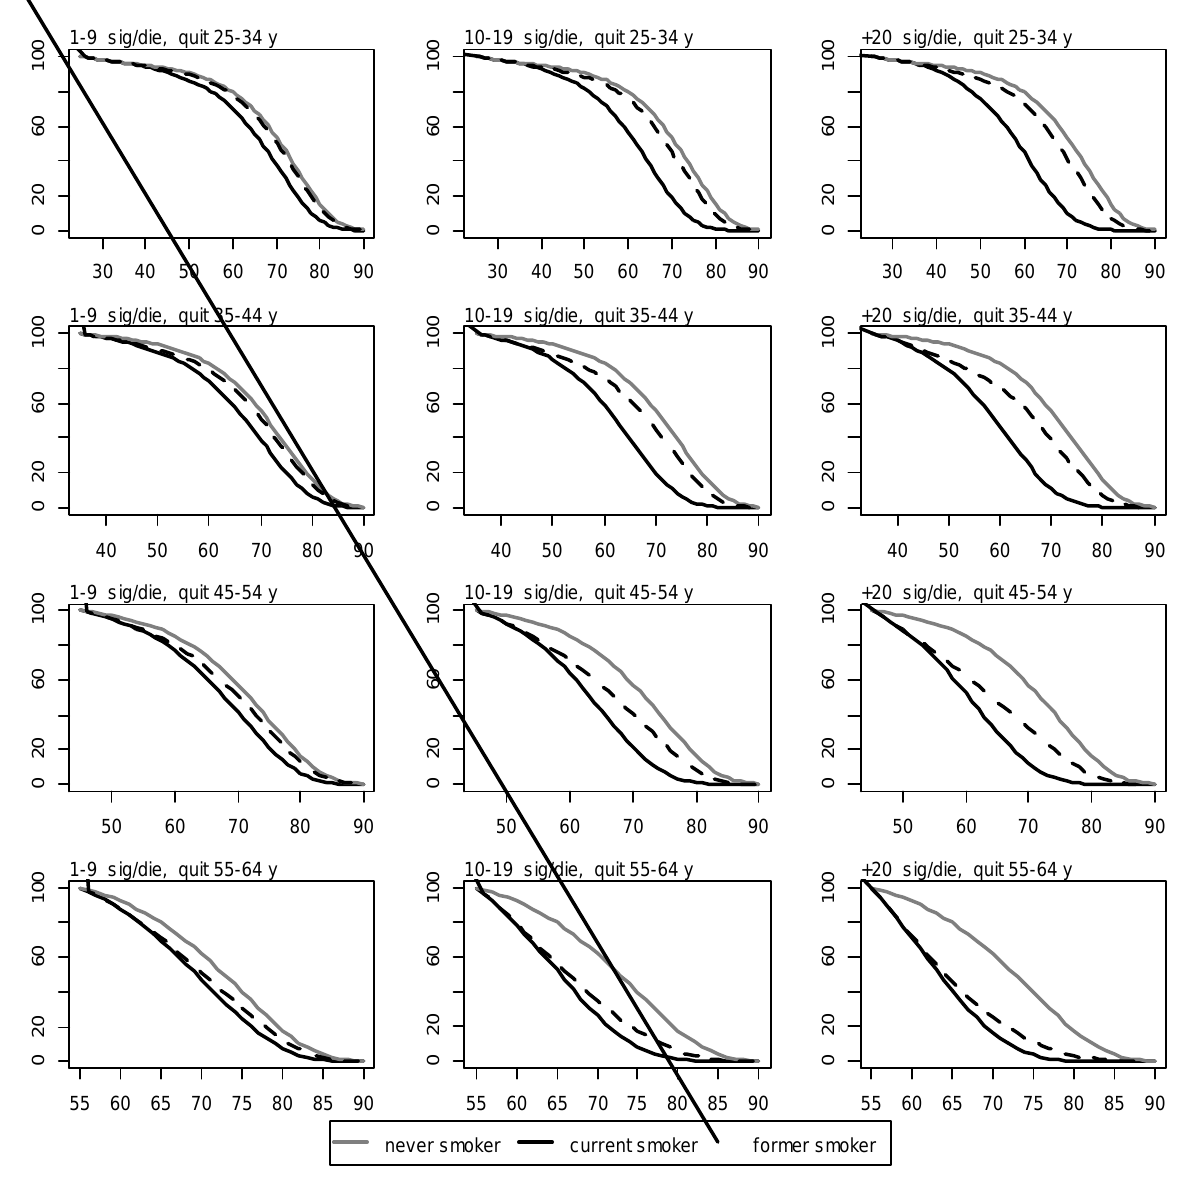
Figure 3. Survival for never, current, and former men smokers by number of cigarettes smoked per day and age of quitting. y axis: proportion of survival. x axis: age in